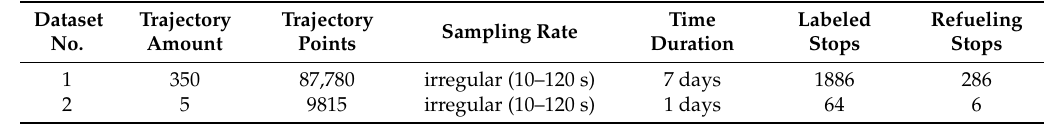
Table 1. Details of different datasets.